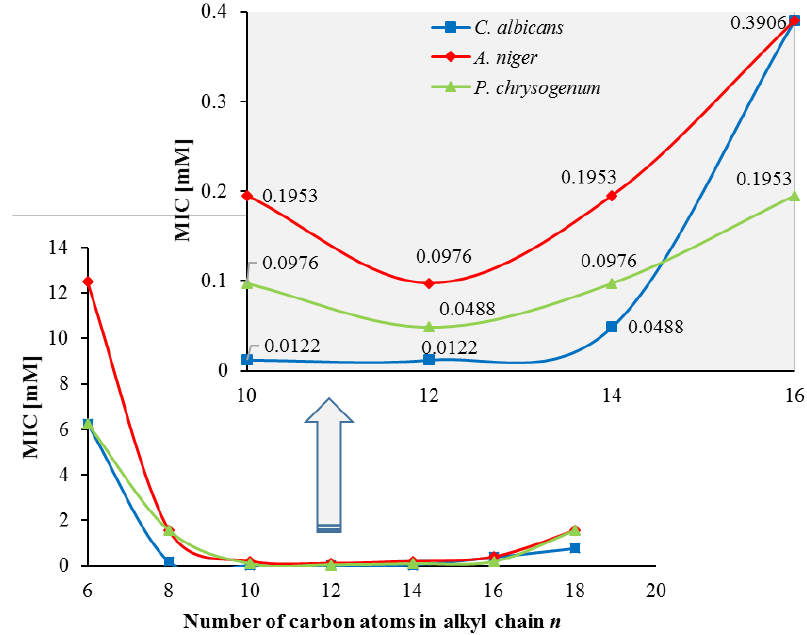
Figure 11. Antifungal activity of compounds 2 – 9 .